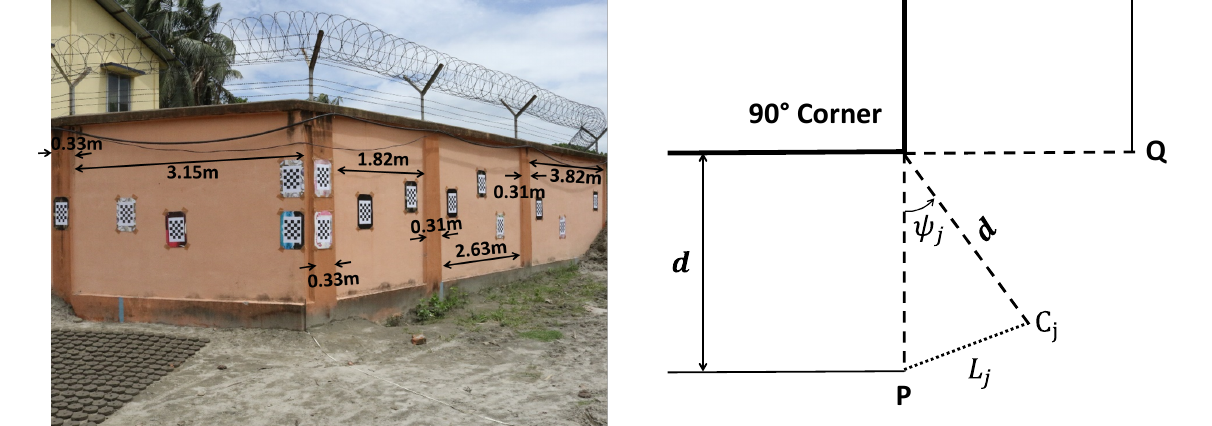
Figure 7. Schematic view of marking camera position in field for